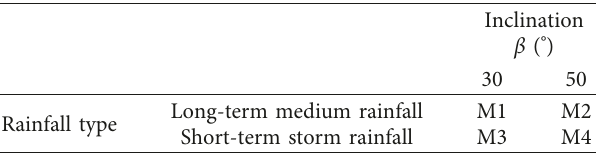
Table 5: Summary of model test sets and related factors.